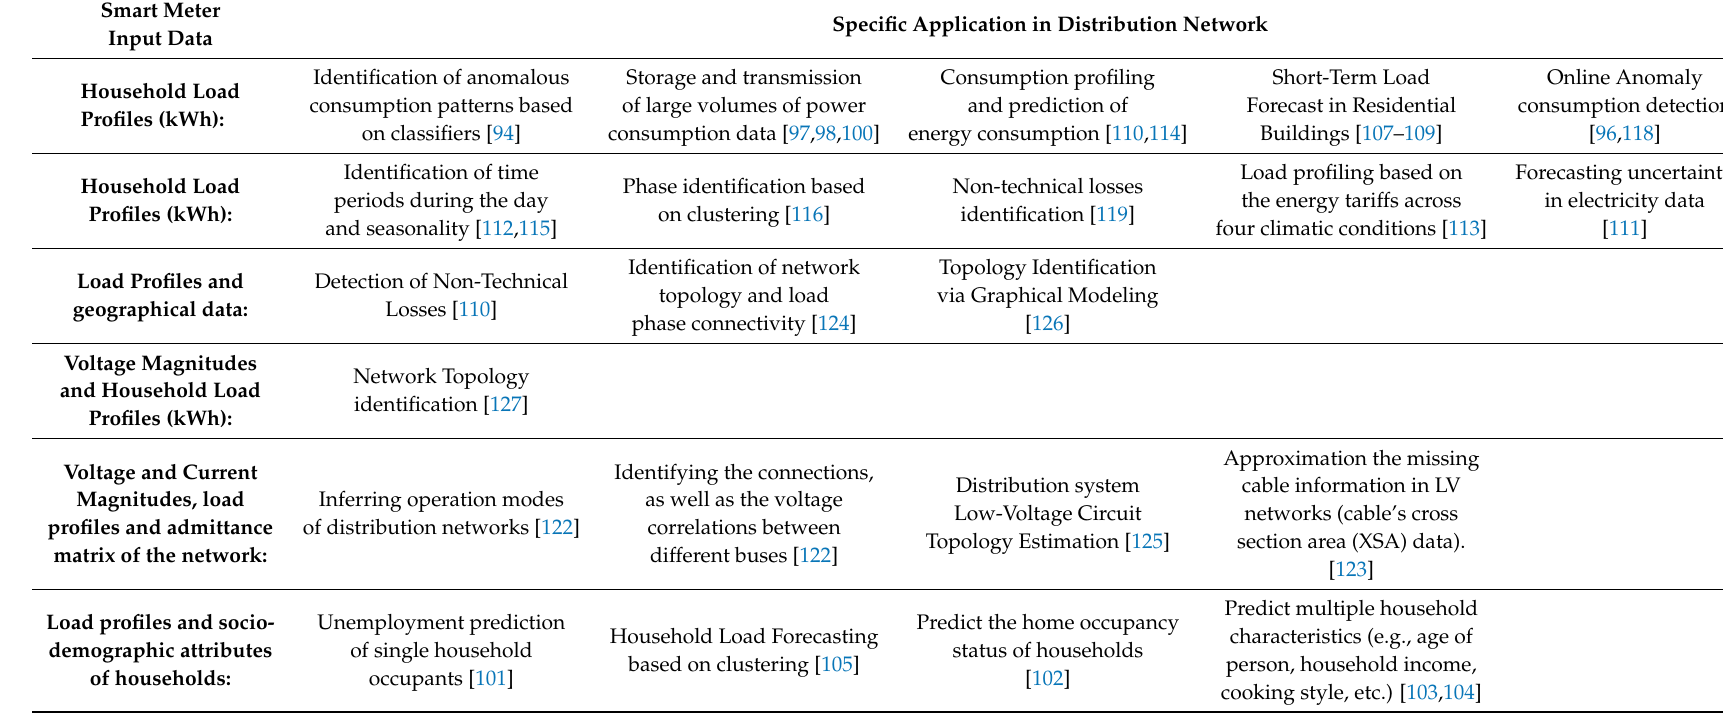
Table 5. Specific Application of Smart Meter